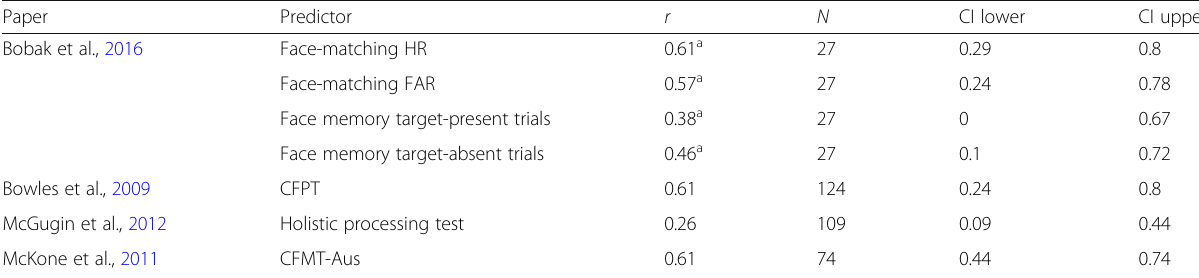
Table 1 Literature measuring correlation with the Cambridge Face Memory Test